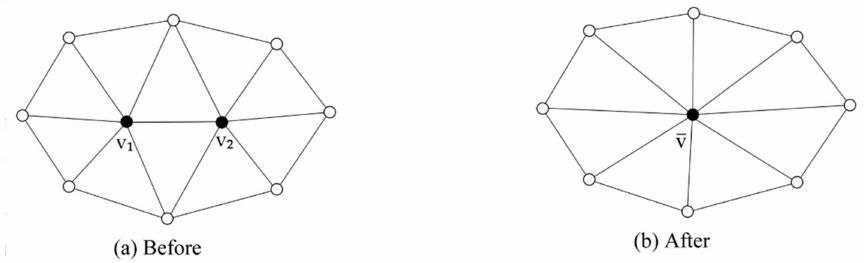
Figure 1. Sketch of the edge collapse operation. ( a ) represents the mesh before edge collapse, and ( b ) represents the mesh after edge collapse. The triangles between v 1 and v 2 are deleted after edge